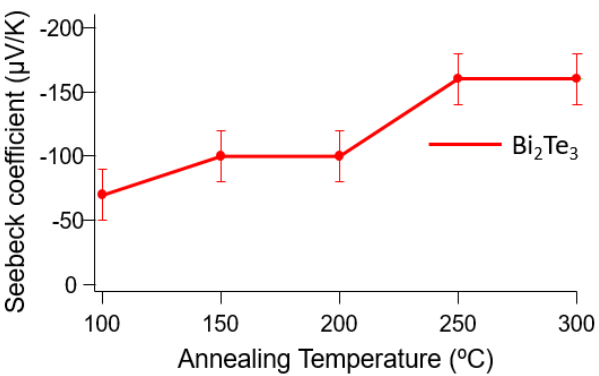
Figure 15. Dependence of the Seebeck coefficients on the annealing temperature.